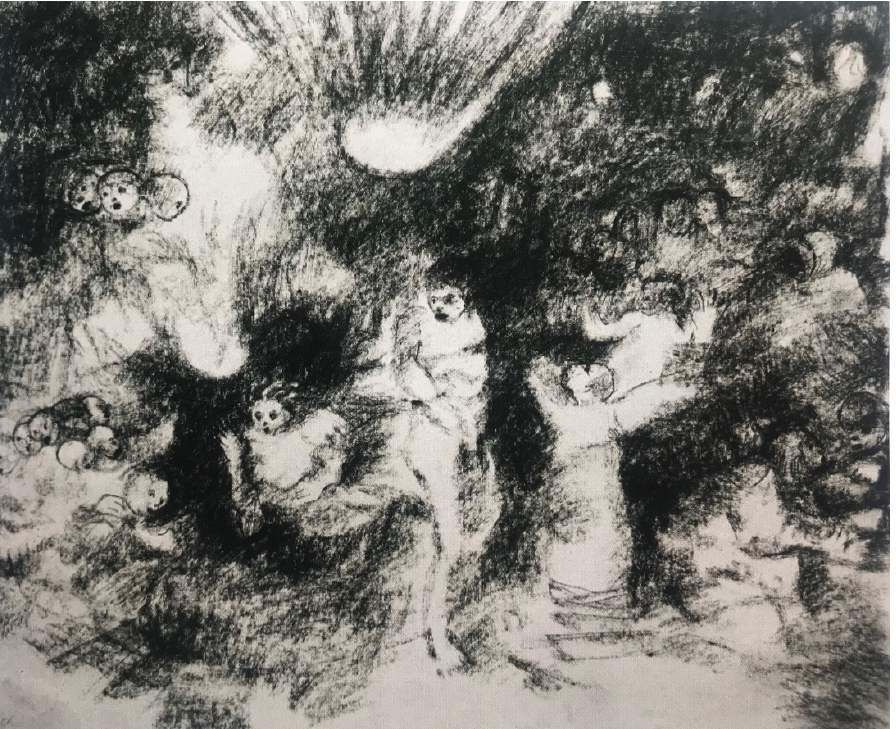
Figure 11. Vasily Chekrygin, The Raising of the Dead , 1922, pencil and charcoal on paper, collection of K.I. Grigorishin, Moscow.